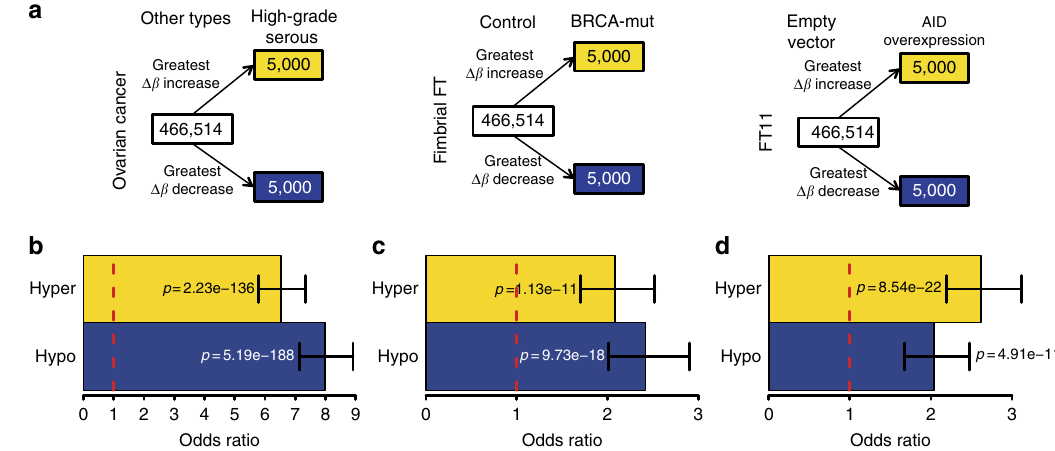
Figure 6 | Preservation of AID-mediated reprogramming in high-grade serous cancers. ( a , left) 5,000 CpGs with the greatest b increase and decrease in high-grade serous ovarian cancer ( n ¼ 124) compared with non-serous ovarian cancer types ( n ¼ 36) (clear cell, endometrioid and mucinous) were selected. (middle) 5,000 CpGs with the greatest median b increase and decrease in fimbrial compartments of BRCA mutation carriers compared with non-carriers were selected (called hyper- and hypomethylated respectively). (right) 5,000 CpGs with the greatest b increase and decrease in primary cultures of FT11 cells force-expressing AID compared with cells transfected with an empty vector were selected. ( b ) The 5,000 most hypermethylated and 5,000 most hypomethylated CpGs in fimbrial ( BRCA mutation carriers versus control) were tested for overlap with the 5,000 CpGs showing the greatest b increase and decrease, respectively, in high-grade serous carcinomas compared with non-serous subtypes (clear cell, endometrioid and mucinous). ( c ) The 5,000 CpGs showing the greatest b increase and decrease in serous carcinomas compared with other cancer types were tested for overlap with those 5,000 CpGs showing the biggest increase and decrease in methylation, respectively, in cultured cells force-expressing AID compared with cells transfected with empty vector. ( d ) The 5,000 most hyper- and hypomethylated CpGs in fimbrial samples ( BRCA mutation carriers versus control) were similarly tested for overlap with the 5,000 CpGs with greatest b increase and decrease, respectively, in the cultured cells force-expressing AID. All p -values were derived using Fisher’s exact test; all error bars indicate 95% confidence intervals on the estimated odds